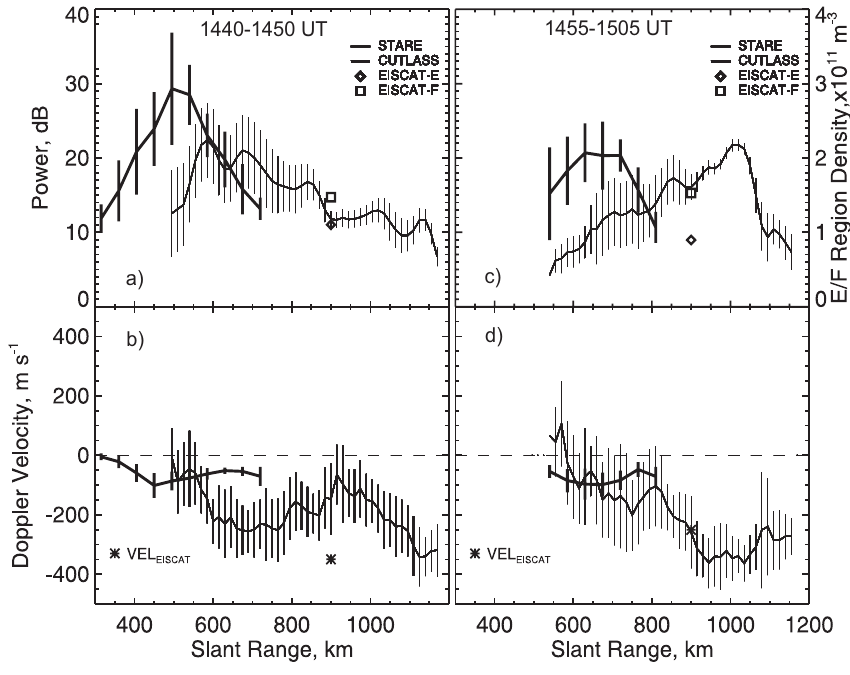
Fig. 11. Similar to Fig. 7 except for periods when both CUTLASS and STARE observed E-region